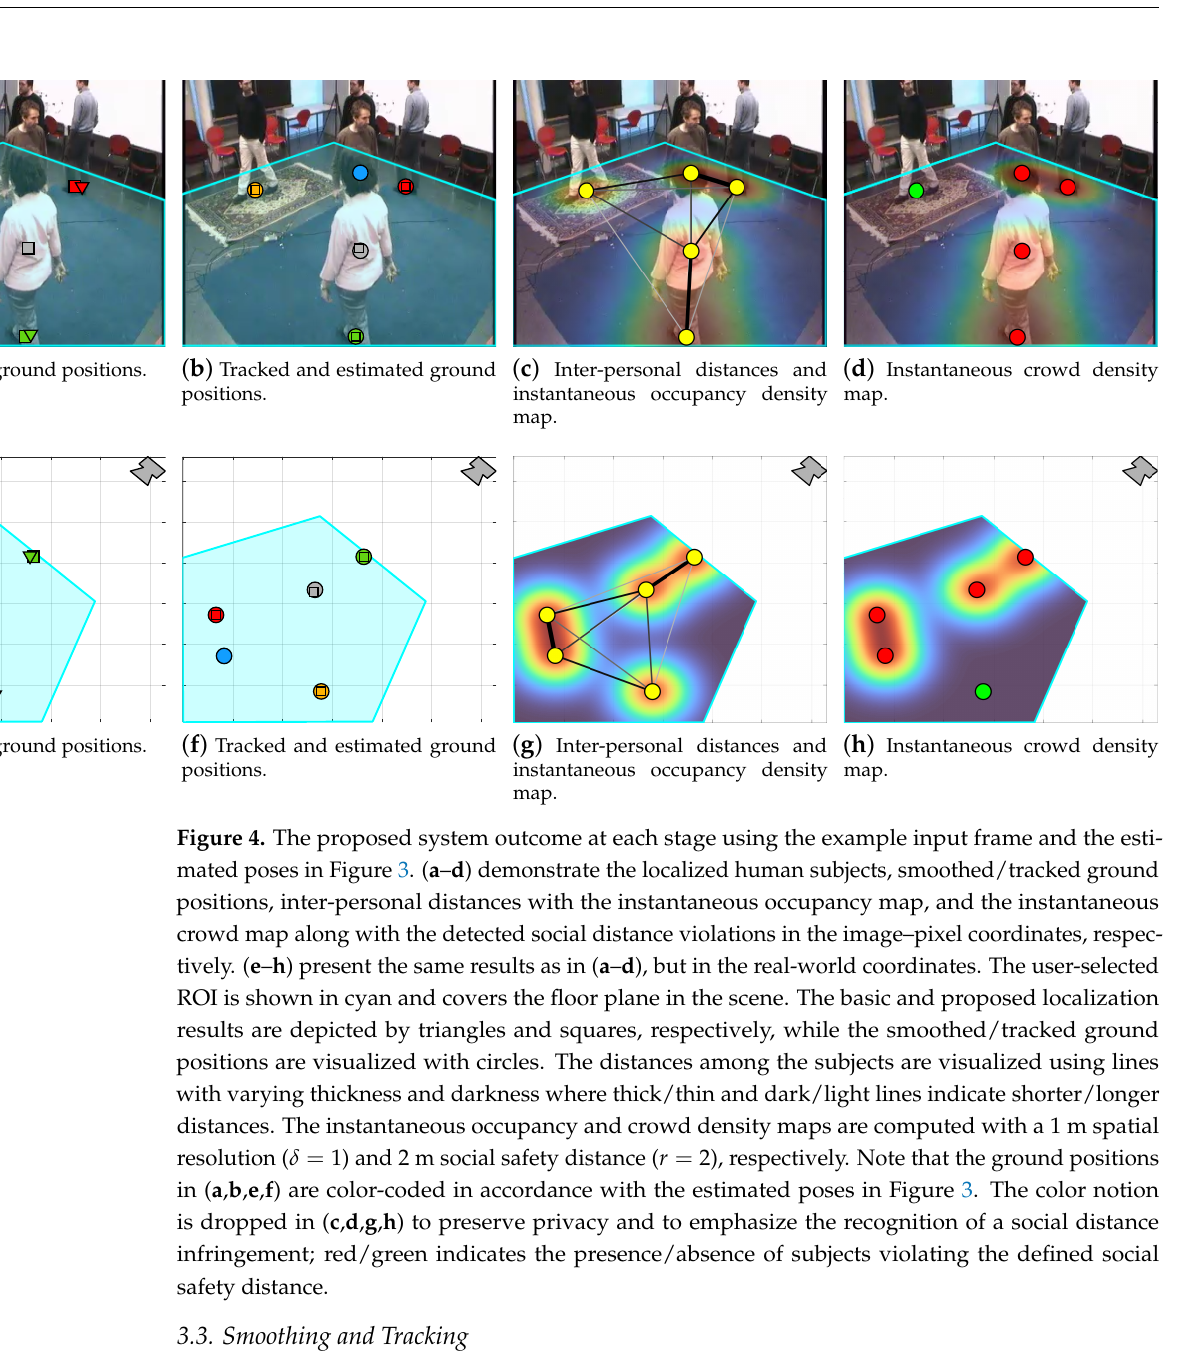
( a ) Estimated ground positions. ( b ) Tracked and estimated ground